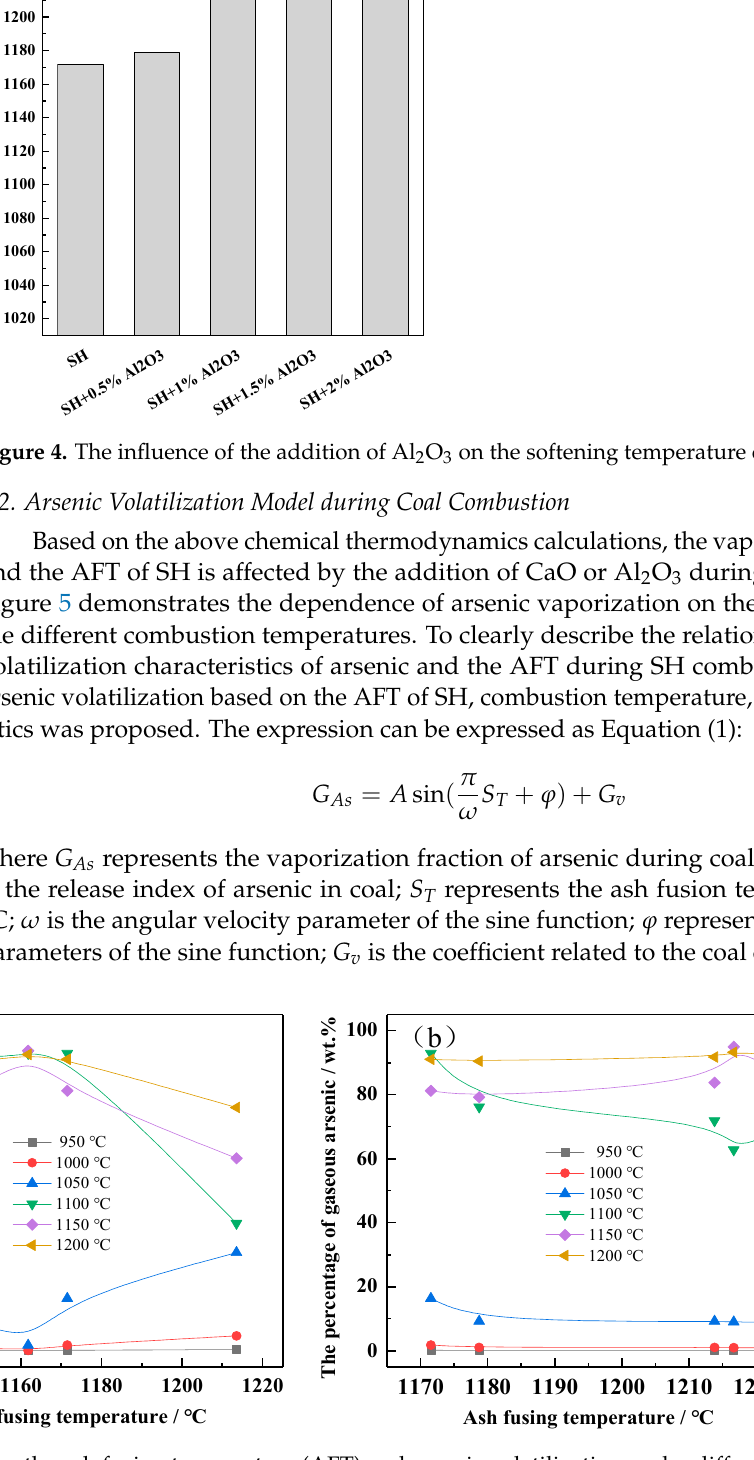
Figure 3. The influence of the addition of CaO on the softening temperature of coal ash.